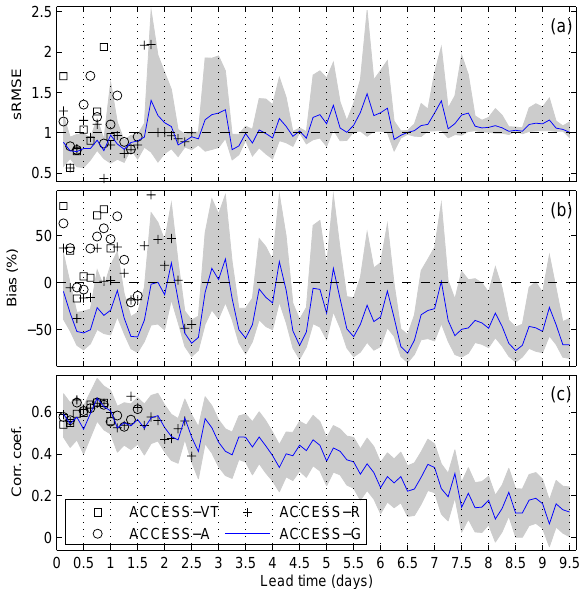
Fig. 6. Evaluation scores of the ACCESS-G model for 3h accumu- lated precipitation forecasts at Carboor Upper station at different lead times: (a) sRMSE, (b) bias, and (c) Spearman rank correla- tion. The shaded area corresponds to the 95% confidence intervals of sampling